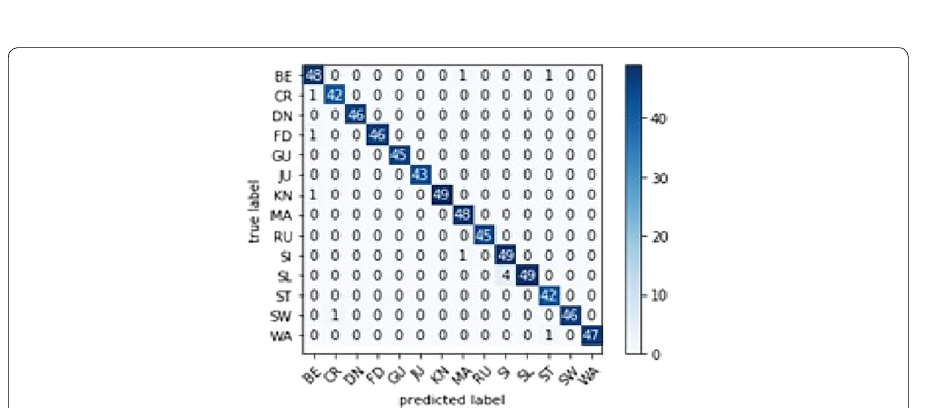
Fig. 11 Confusion matrix for 14 category subset by using deepTrain model of action based